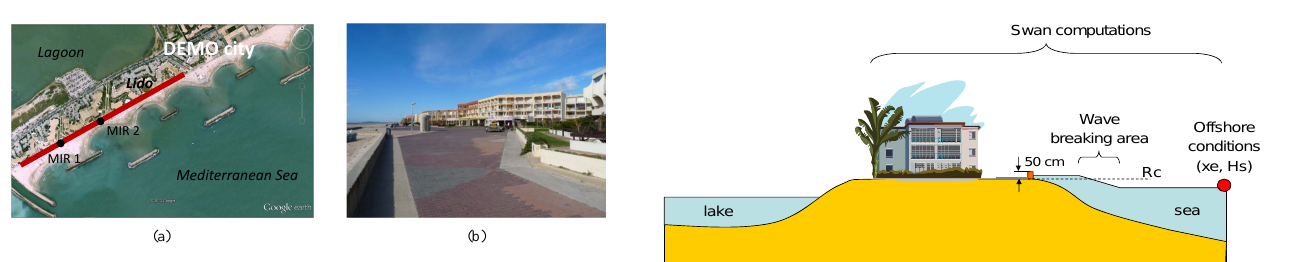
Fig. 3. Cross-shore scheme of the study